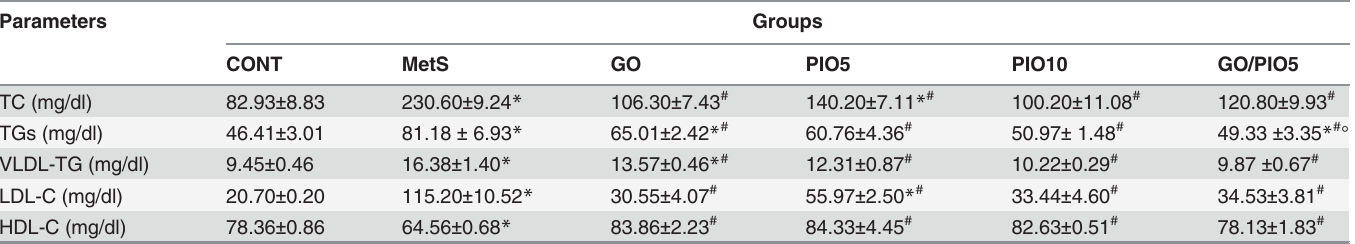
Table 3. Effect of 4 weeks daily oral administration of geraniol (GO; 250 mg/kg), pioglitazone (PIO; 5 and 10 mg/kg), and GO with PIO5 on serum total cholesterol (TC), triglycerides (TGs), very low density lipoprotein-triglycerides (VLDL-TG), low density lipoprotein-cholesterol (LDL-C), and